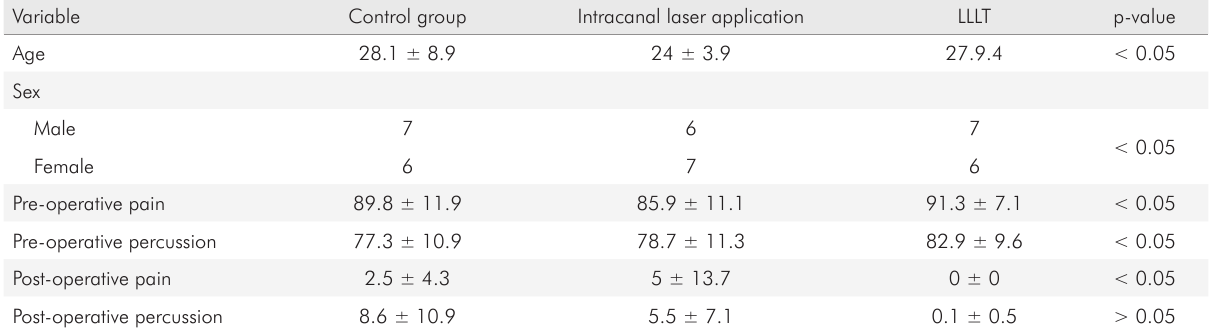
Table. Demographic data and pre- and post-operative (seven days after the root canal treatment) VAS scores according to groups.